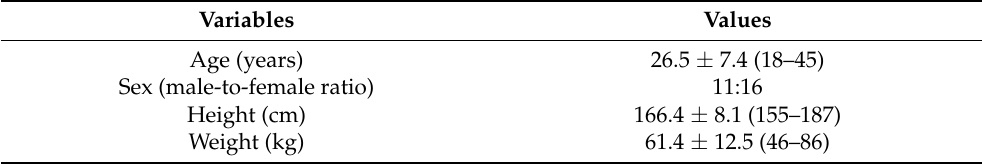
Table 1. Baseline characteristics of the participants (n = 27). Variables Values Age (years) 26.5 ± 7.4 (18–45)